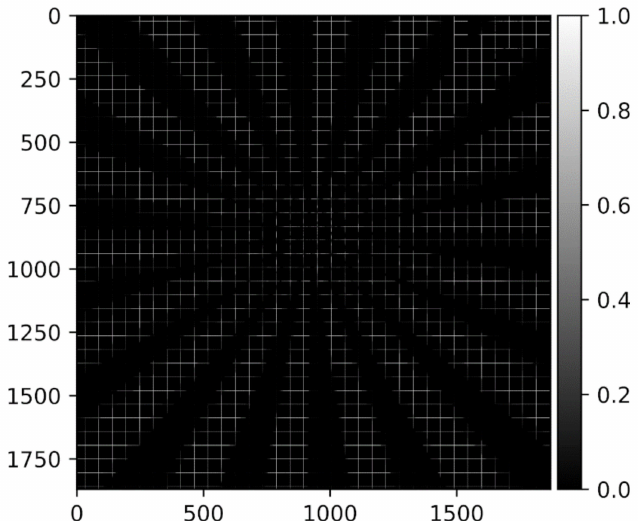
Figure 5. The proof of concept of sub-pixel resolution image formation of a Siemens star, including only one horizontal and one vertical line sample scanning with the sub-pixel shift. Reconstructed 2D sub-pixel resolution image (step size: 1 µ m), which is a sum of the vertical and horizontal 1D sub-pixel resolution images. A complete raster-scan of the sample with 55 × 55 lines would give a complete image, where all areas now white hatched would be white with sharply defined edges. All axes correspond to the sub-pixel